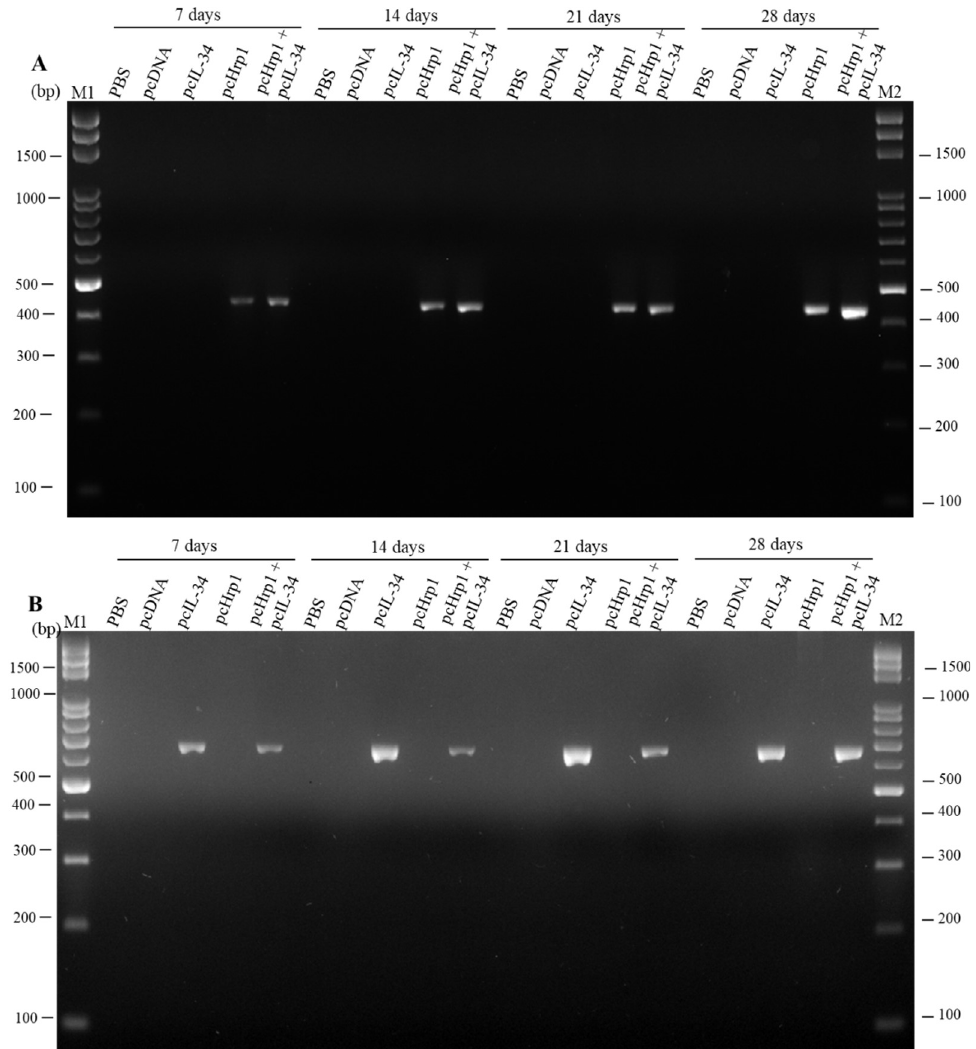
Figure 5. PCR detection of plasmid pcHrp1 and pcIL-34 in muscle tissue of vaccinated fish. ( A ) PCR detection of plasmid DNA pcHrp1 in muscle tissue of vaccinated fish. ( B ) PCR detection of plasmid DNA pcIL-34 in muscle tissue of vaccinated fish. Largemouth bass were injected with phosphate-buffered saline (PBS), or vaccinated with pcDNA3.1, pcIL-34, pcHrp1 and pcHrp1+pcIL-34, respectively. Muscle tissue samples were taken and used for DNA extraction from the vaccinated fish at 7 days, 14 days, 21 days, and 28 days. Lane M1 and M2: 100 bp DNA ladder.